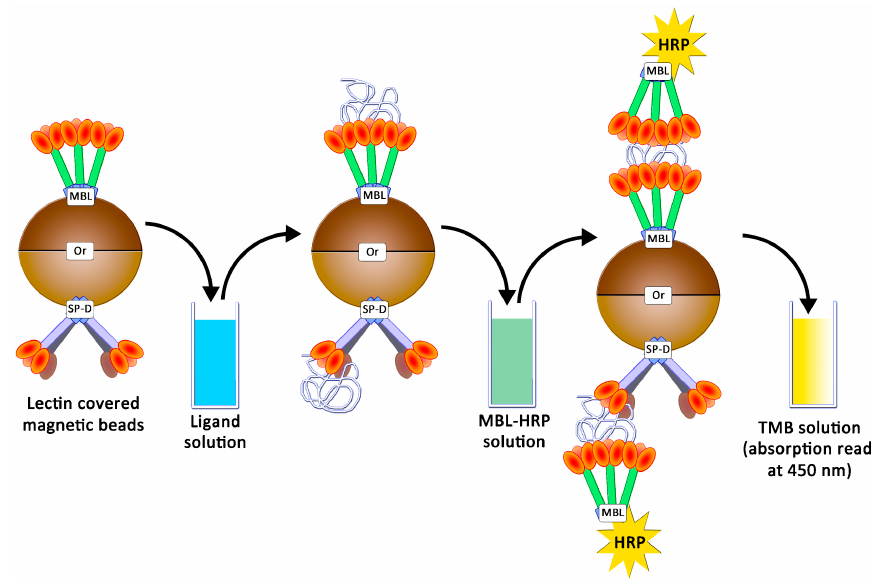
Figure 6. Avidity determination between ligands and lectins following an ELISA-like protocol.